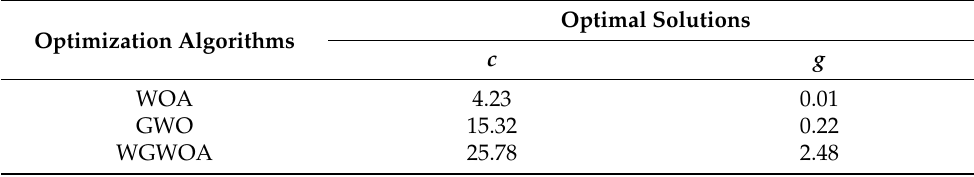
Table 9. Optimal solution of SVM parameters found by different